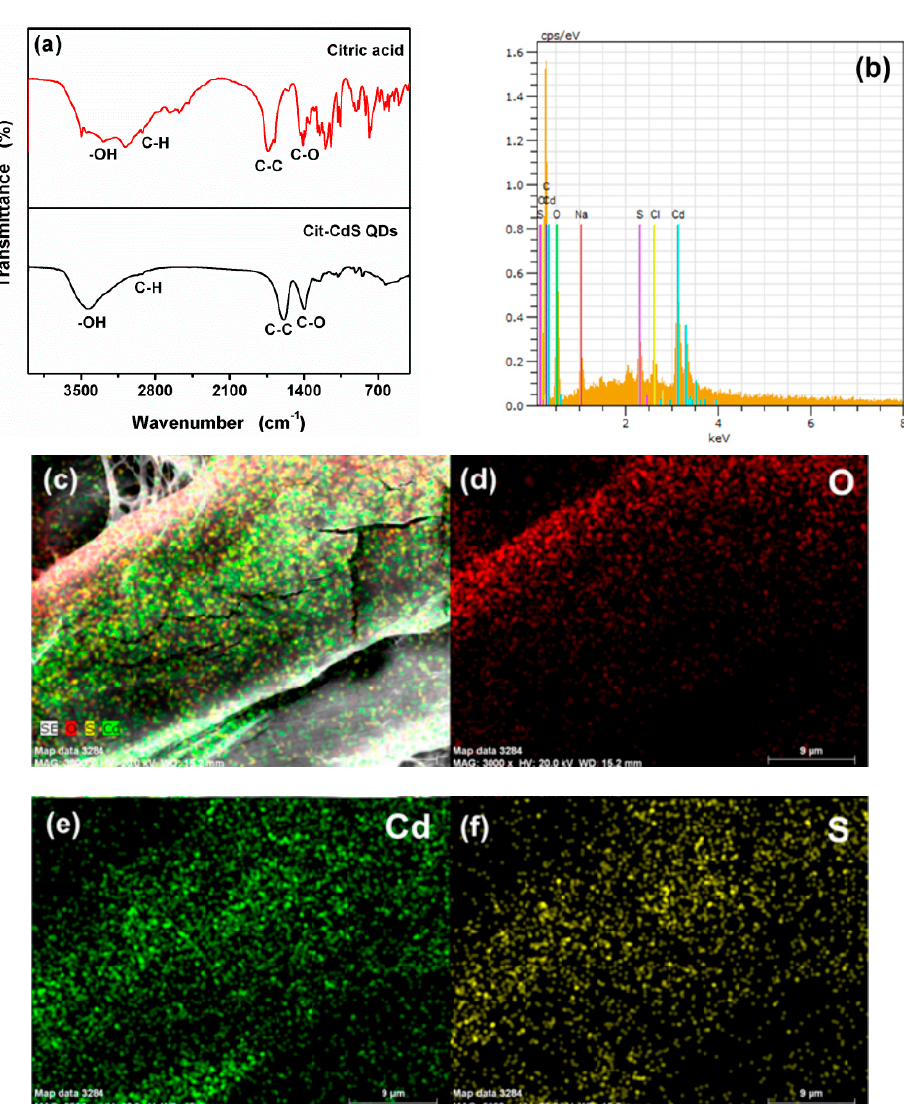
Figure 3. FTIR spectra ( a ), EDX analysis ( b ) and elemental mapping ( c – f ) of the prepared CA- CdS QDs.